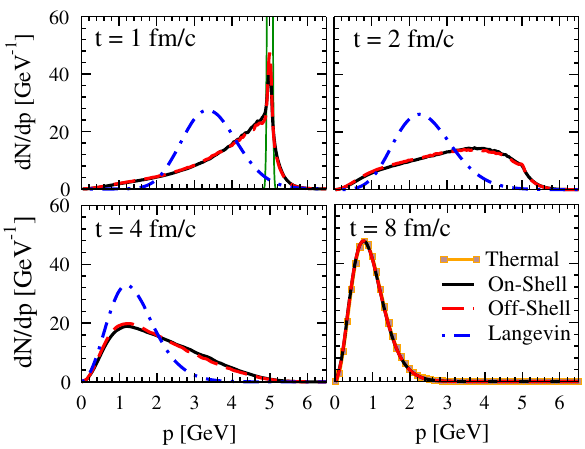
Fig. 13 Charm quark momentum distribution as a function of the charm quark momentum at four different times t = 1 f m / c (left upper / M = 0 . 75 panel) and t = 2 f m / c (right upper panel), t = 4 f m / c (left lower i i panel) and t = 8 f m / c (right lower panel). Black solid lines are for on-shell dynamics, red dashed lines are for off-shell dynamics while blue dash-dotted lines are for langevin dynamics. The solid thin green line is the initial distribution that is the same for each calculations (cid:3) 0 . 3 − 0 . 4 M , but becomes sizeable for case with γ ∗ DQPM γ ∗ / M = 0 . 75. However the pure off-shell dynamics